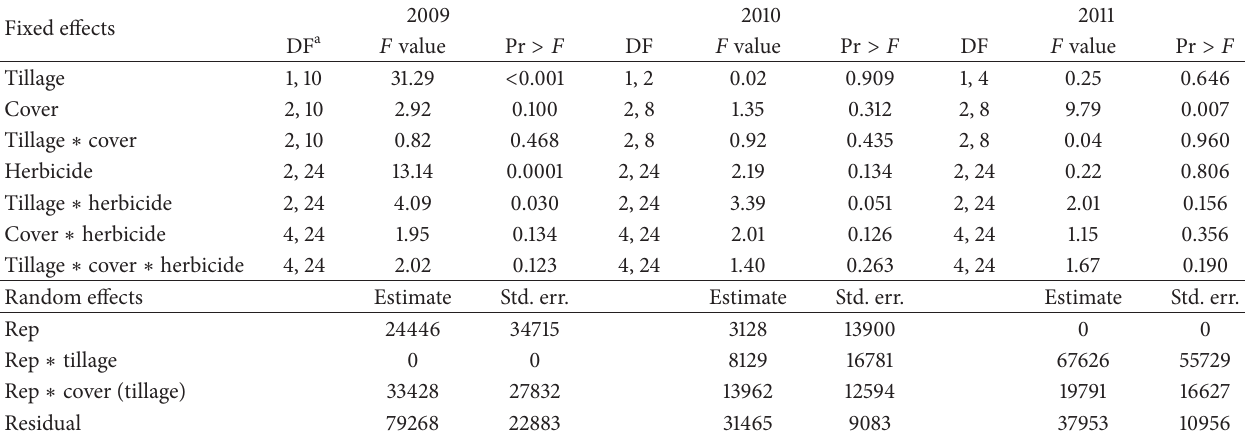
Table 5: Analysis of variance and variance-component estimates for the net returns from cotton production by year.